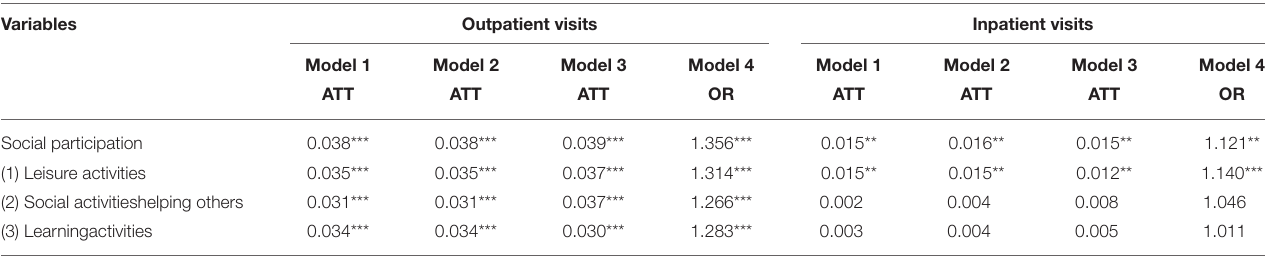
TABLE 5 | The average treatment effect of propensity score matching among three matching methods and logistic regression.